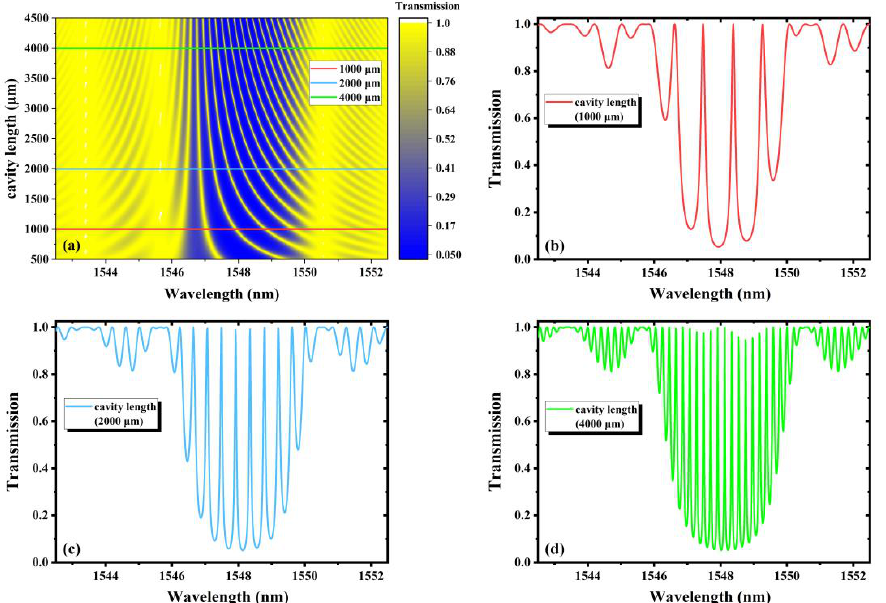
Figure 2. ( a ) The transmission spectra with continuous variation in cavity length from 500 μm to 4500 μm ; the transmission spectra with cavity length of ( b ) 1000 μm, ( c ) 2000 μm and ( d ) 4000 μm.